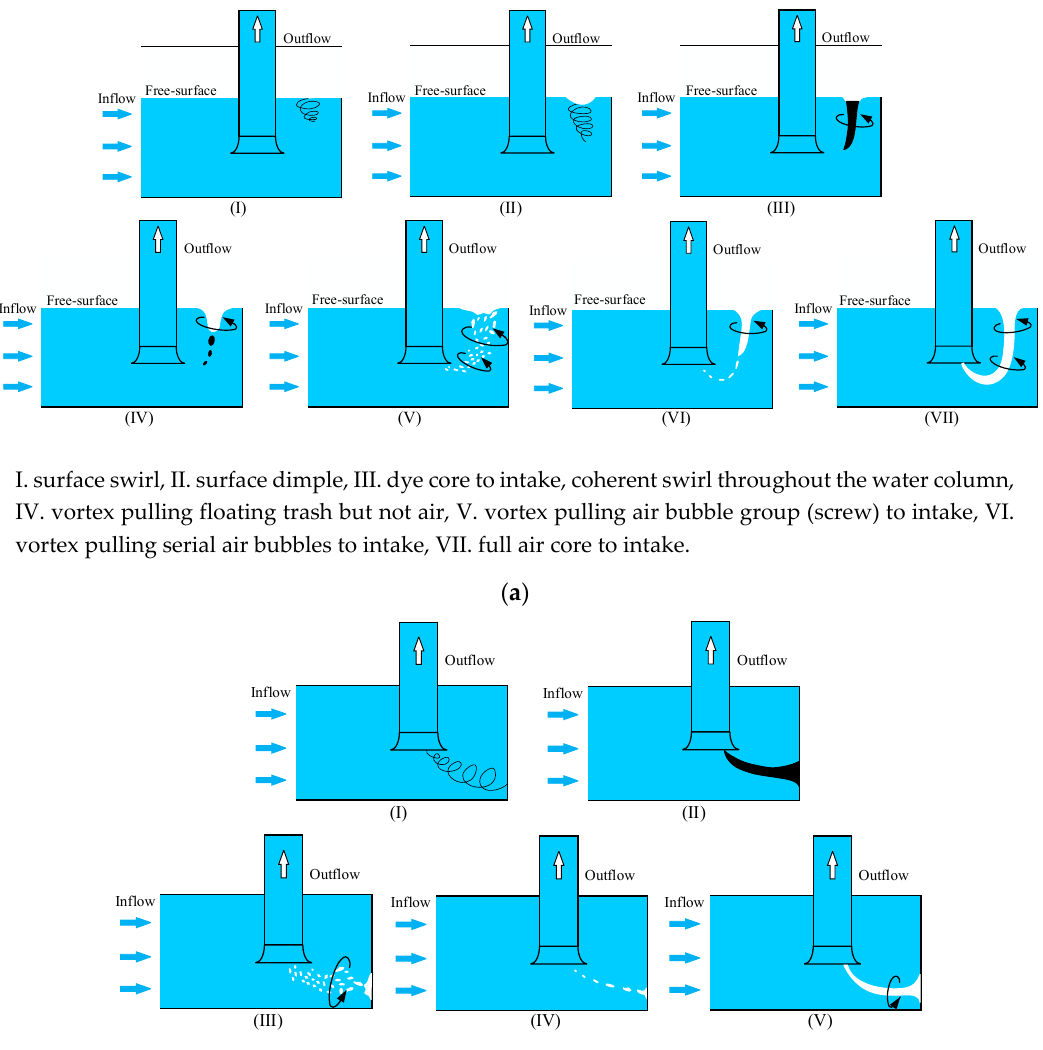
Figure 4. Vortex classification. ( a ) Free-surface vortex. ( b ) sub-surface vortex.